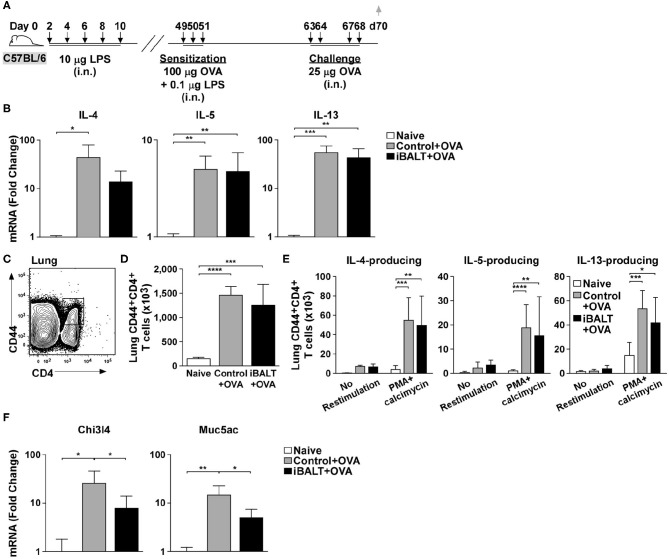
The presence of iBALT impacts allergic airway disease downstream of Th2 cytokine expression. (A) Timing of iBALT induction, allergic sensitization, antigen challenge and tissue collection. (B) mRNA expression of IL−4, IL−5, and IL−13 was determined by quantitative PCR. Data is normalized to the expression in naïve lung. (C–E) Lung cells from OVA primed and challenged mice were restimulated with PMA/calcimycin for 4 h and we determined the frequencies (C) and numbers (D) of CD4+CD44hi T cells as well as the numbers of cytokine–producing CD4+ T cells (E) by intracellular staining and flow cytometry. (F) mRNA expression of Chi3l4 and Muc5ac was determined by quantitative PCR. Data is normalized to the expression in naïve lung. All data show mean ± SD of 5 mice per group; *P < 0.05, **P < 0.01, ***P < 0.001, ****P < 0.0001. Experiments were performed 3 times (B,F) or 4 times (C–E).